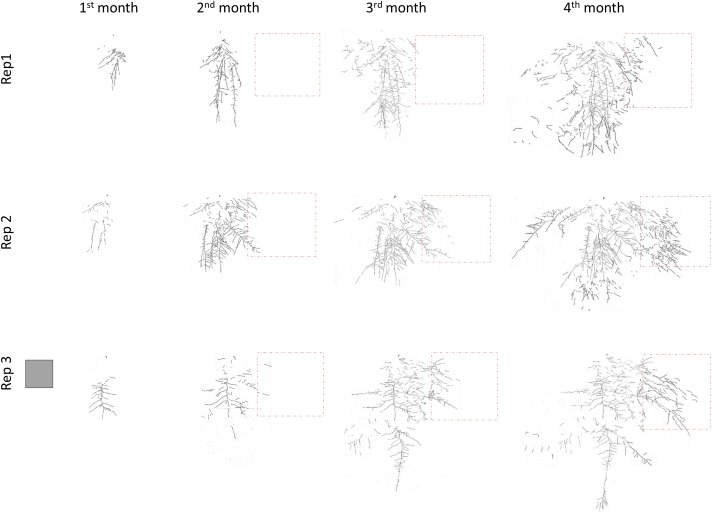
Development of L. scoparium roots growing in the three replicates of patch (P) treatment in the rhizobox experiment. The gray square represents the scale of 10 cm × 10 cm. The orange square represents the area where the patch of biosolids was located.